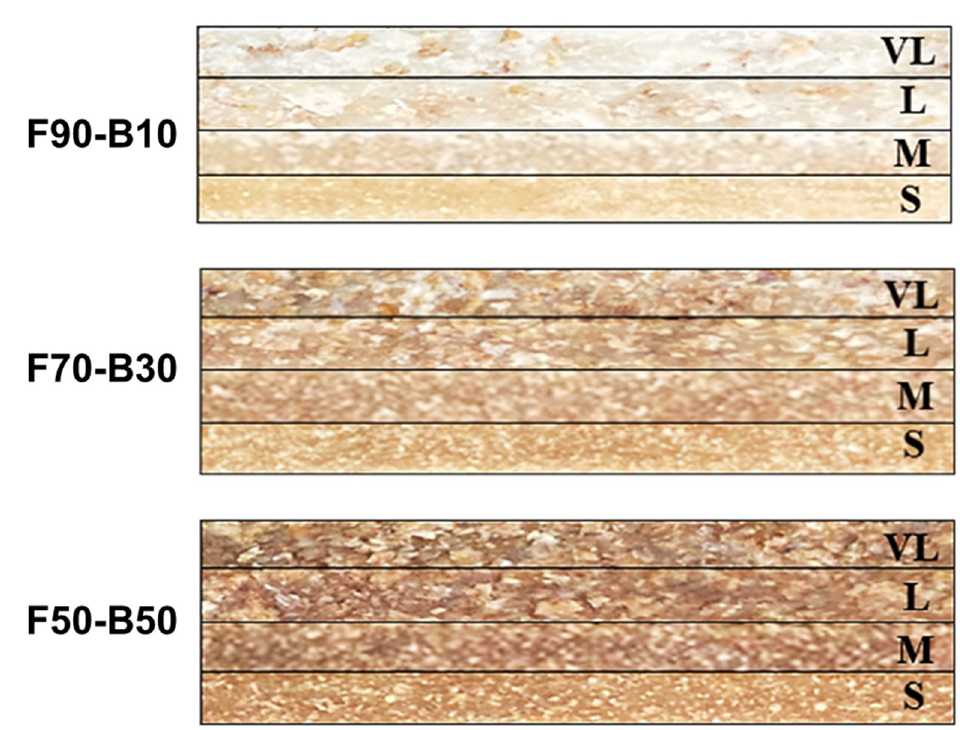
Figure 2. Appearance of fresh noodles prepared with flour-bran blends at different blending ratios and bran sizes. VL, L, M, and S indicate the brans with very large, large, medium, and small particle sizes.